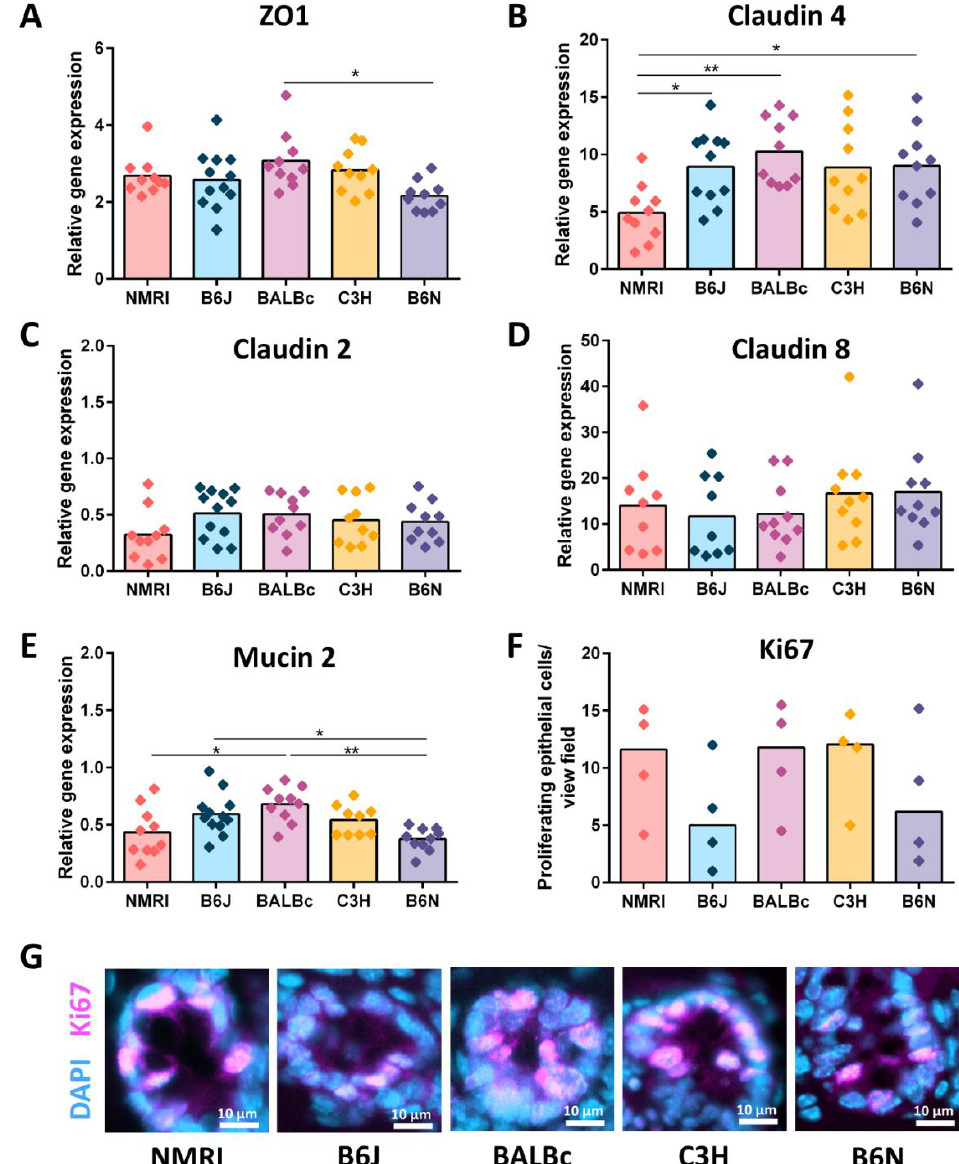
Figure 3. Involvement of epithelial barrier factors in cecal enlargement. ( A – D ) Gene expression of epithelial tight junctions: ( A ) ZO1, ( B ) Claudin 4, ( C ) Claudin 2, and ( D ) Claudin 8 measured by qPCR in total RNA isolated from the cecal tissue of five GF strains (NMRI, B6J, BALBc, C3H and B6N). Relative differences in gene expression were calculated by the comparative 2 − ∆∆ Ct method. Statistical differences were calculated by one-way ANOVA with a Tukey’s post-hoc test * p < 0.05, ** p < 0.01. Box plot indicates mean. Each symbol represents one independent sample. ( E ) Gene expression of mucin 2 measured by qPCR in total RNA isolated from cecal tissue of five GF strains (NMRI, B6J, BALBc, C3H and B6N). One-way ANOVA with Tukey’s post-hoc test * p < 0.05, ** p < 0.01. Box plot indicates mean. Each symbol represents one independent sample. ( F ) Quantification of proliferating epithelial cells (Ki67+ cells) in the cecal tissue of five GF strains (NMRI, B6J, BALBc, C3H and B6N; n = 4). Kruskal-Wallis test with Dunn´s multiple comparison test. Box plot indicates median. Each symbol represents one independent sample. ( G ) Representative immunostaining for Ki67 (violet) on cecal sections obtained from five GF strains (NMRI, B6J, BALBc, C3H and B6N; n = 4). Nuclei (light blue) were counterstained with DAPI. Scale bars 50 µ m. Abbreviations: ZO-1, Zonula occludens 1; GF,